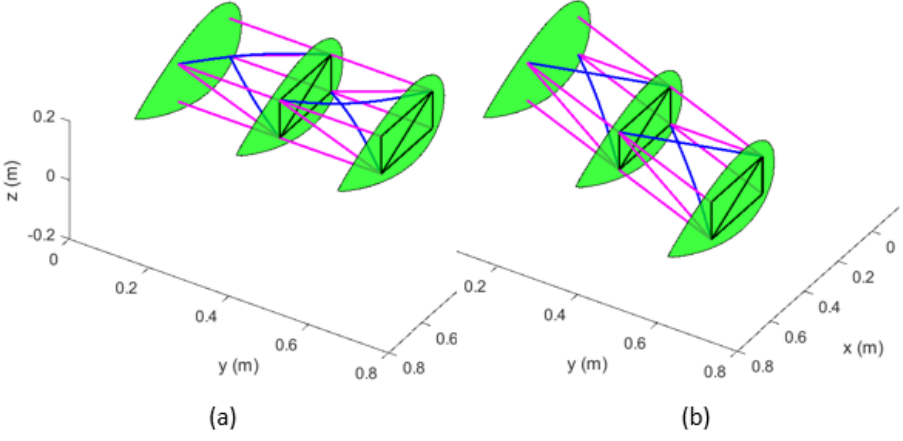
Figure 11. Third mode shape for the system in the ( a ) un–morphed configuration, ( b ) morphed configuration (simulation 25).